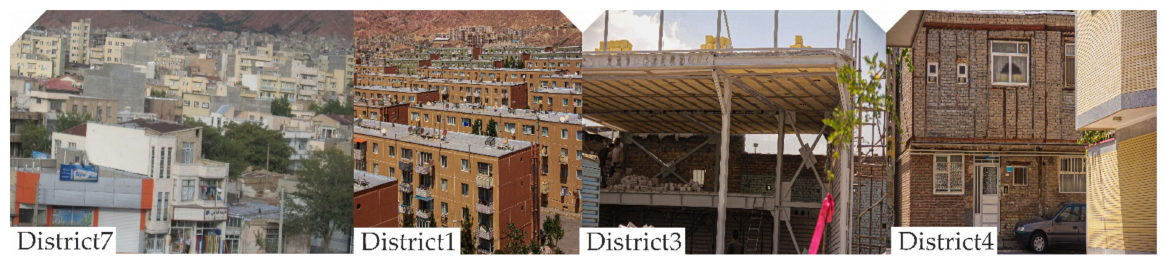
Figure 10. RC moment-resisting or shear-wall frame building.